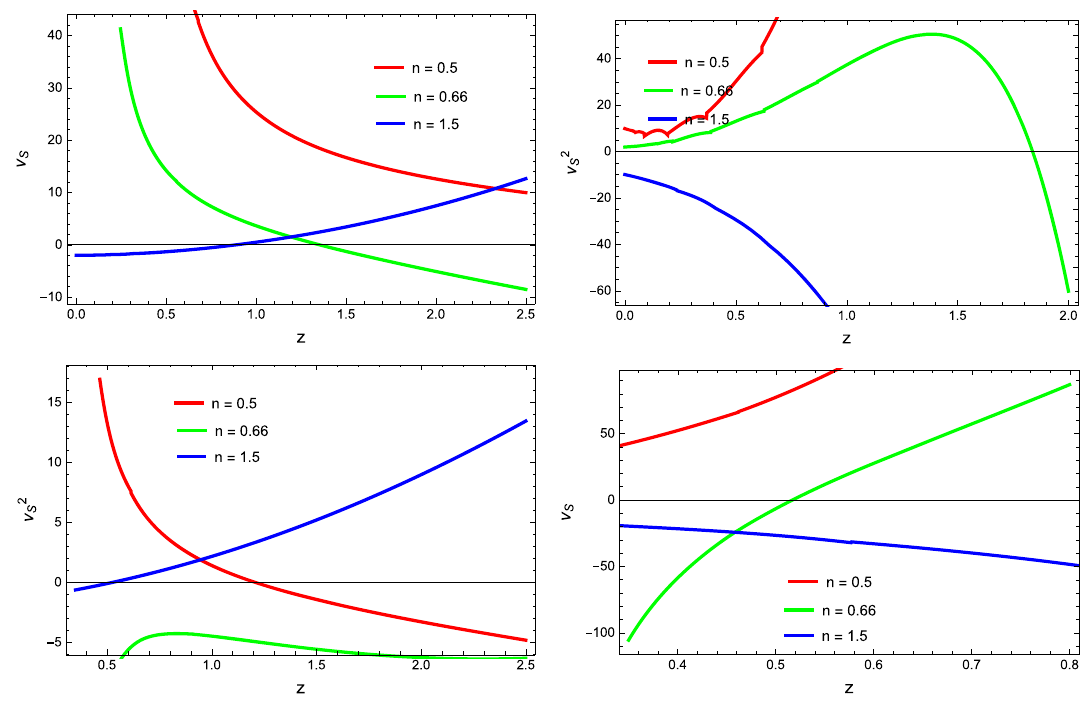
Fig. 2 Plots for Power-law squared speed of sound versus z